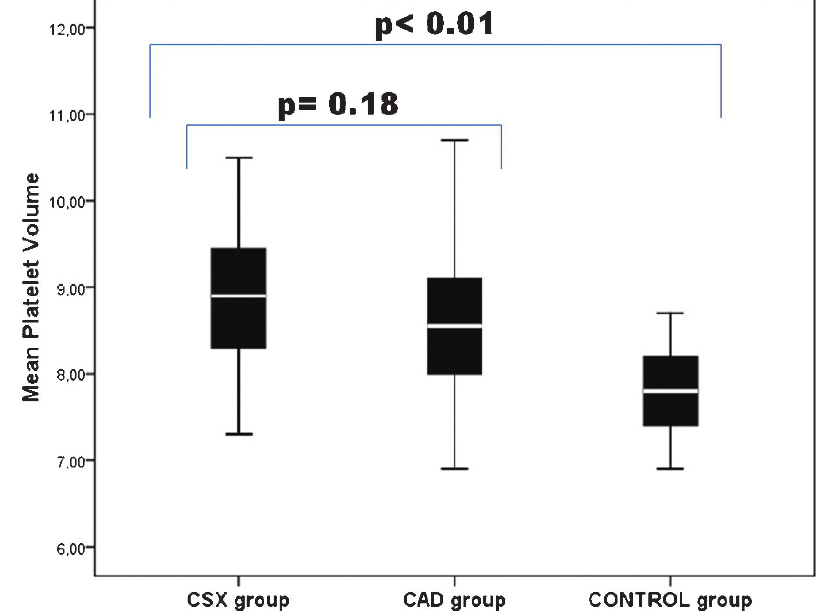
Figure 1 - The MPV measurements of the three groups. There were no statistically significant differences in the MPV measurements between the CSX and the CAD groups ( p= 0.18). Compared with the controls, the patients with either CSX or CAD exhibited significantly increased MPVs ( p ,